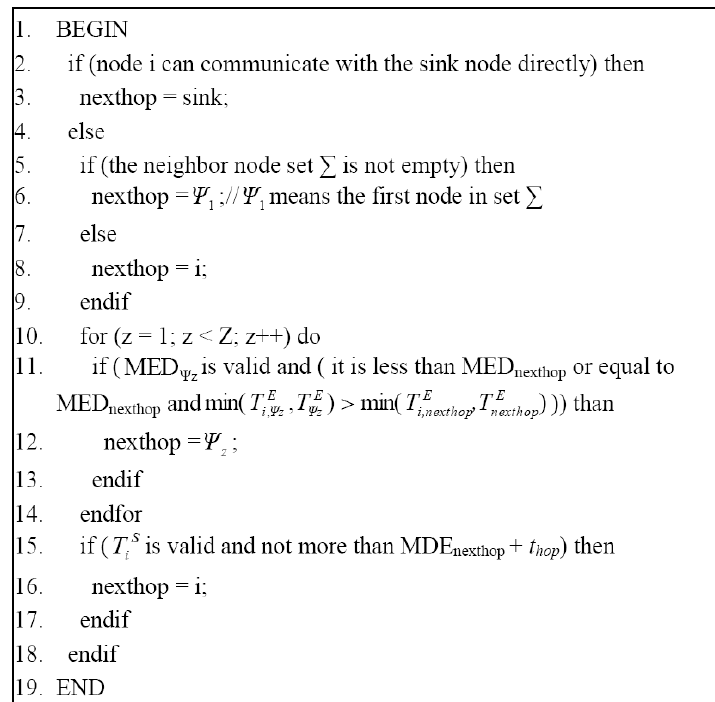
Figure 3. Pseudo-code of the routing